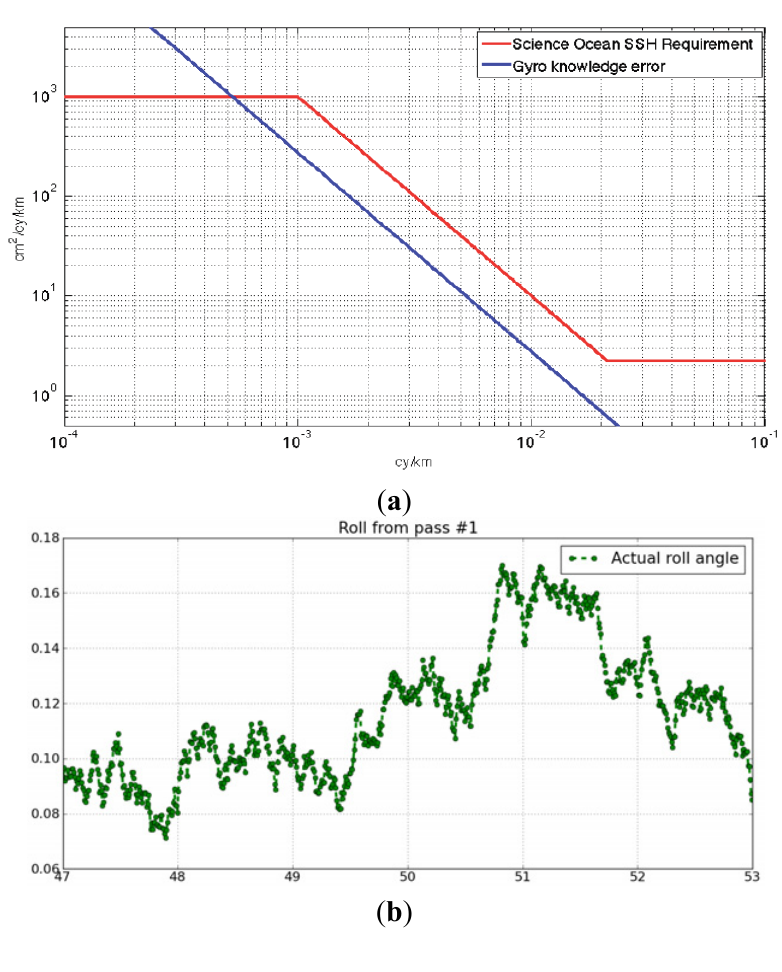
Figure 2. ( a ) shows an example of roll error budget allocation (blue) with respect to the total SSH requirement (red). ( b ) shows a sample of along-track roll segment (in arcsec) as function of latitude. The roll sample from (b) follows the blue spectral law from